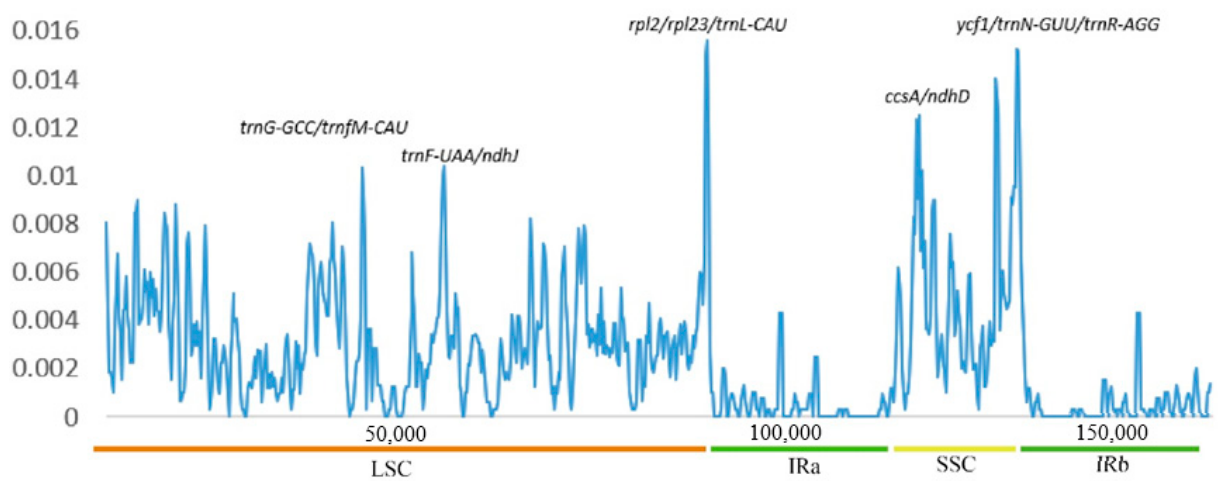
Figure 8. Nucleotide diversity of different regions of Rutaceae chloroplast genome (horizontal axis represents the midpoint of the window, and vertical axis represents the nucleotide diversity of the window Pi